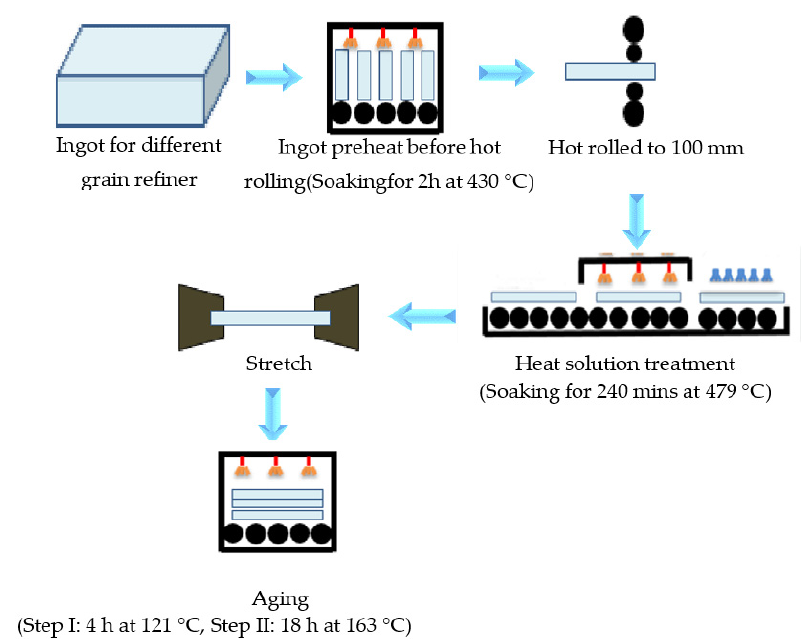
Figure 2. Scheme of the preparation process of the studied 7050 ‐ T7651 plate.